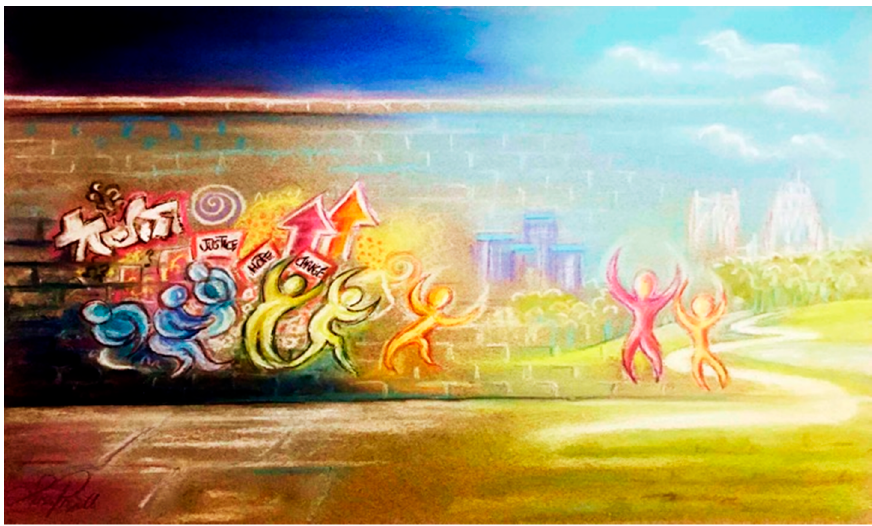
Figure 5. The unequal burden of the Anthropocene. The personal, social and economic challenges of the Anthropocene are shouldered disproportionately by those who have the least resources to cope with adversity. Achieving planetary health requires addressing inequities and recognising that the resiliency at all scales is dependent upon equity and diversity. Art by S.L.P.